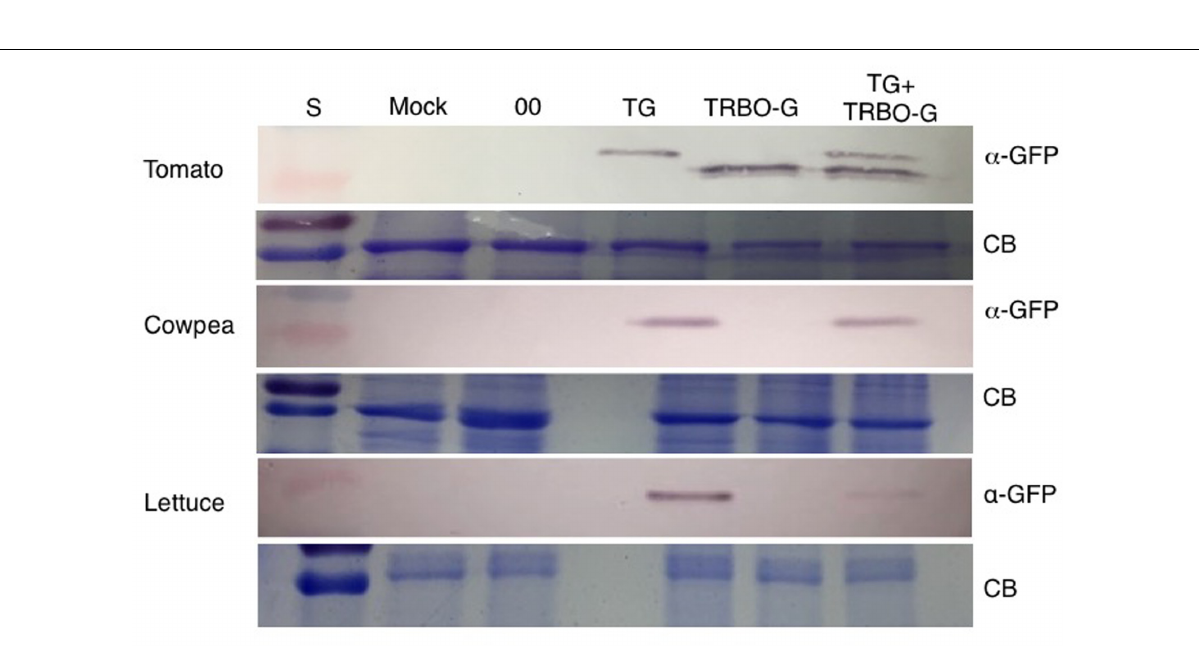
Frontiers in Plant Science |